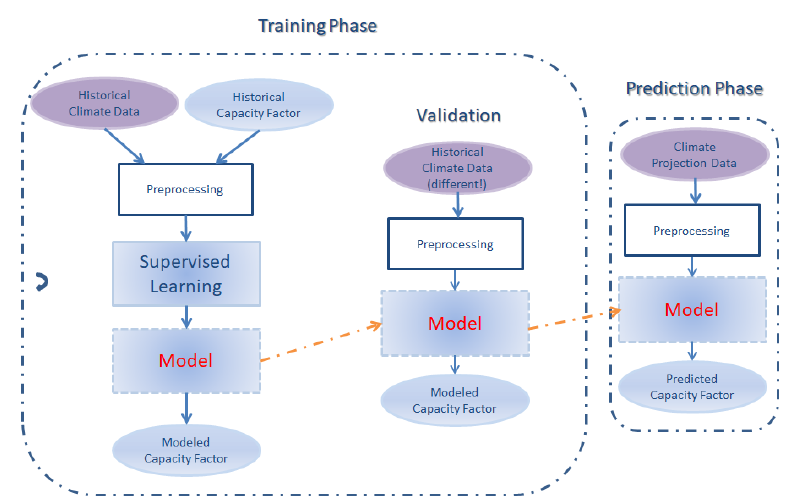
Figure 1. Machine learning